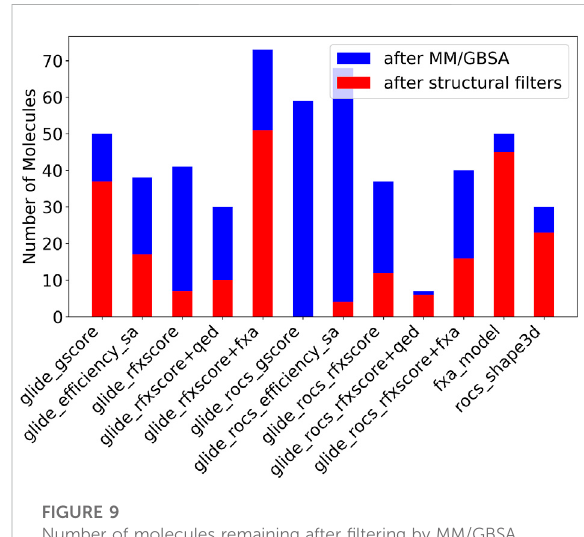
FIGURE 9 Number of molecules remaining after fi ltering by MM/GBSA (blue + red) and unwanted fragments (red).